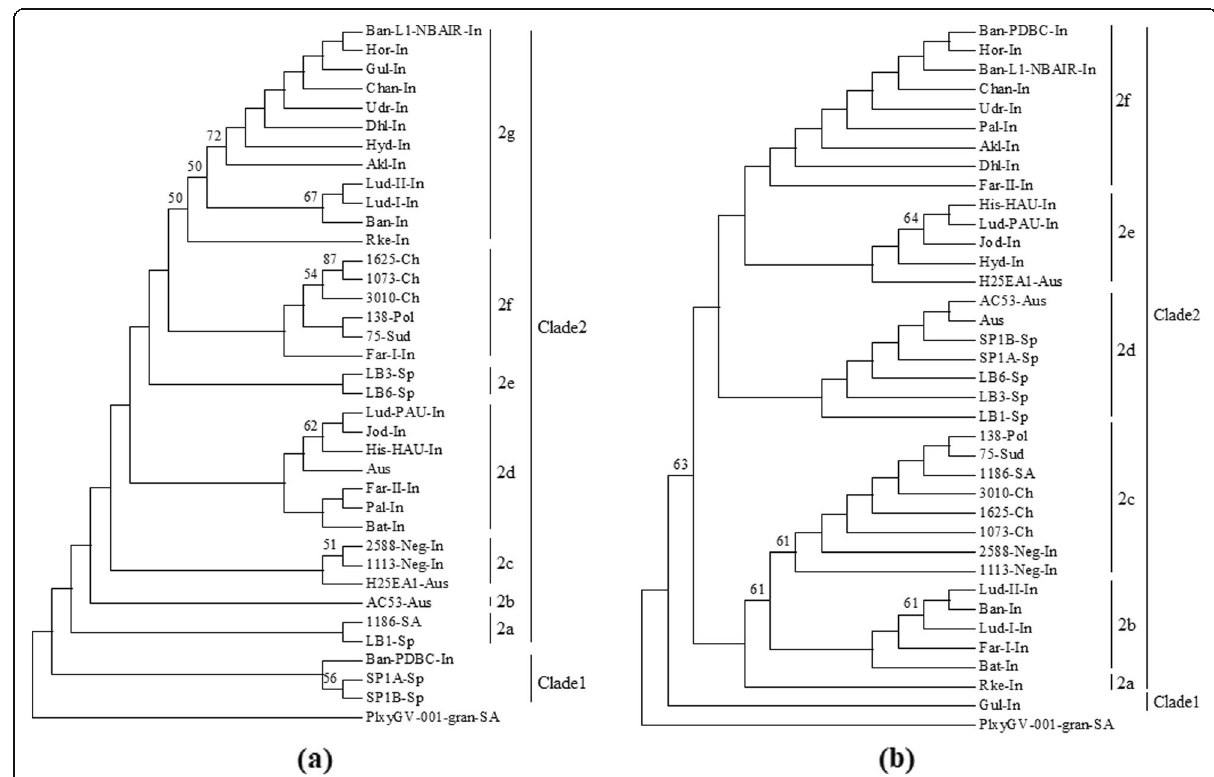
Fig. 2 Phylogenetic tree based on polyhedrin nucleotide ( a )/ deduced amino acid sequences ( b ) of Hear NPV isolates from different geographical